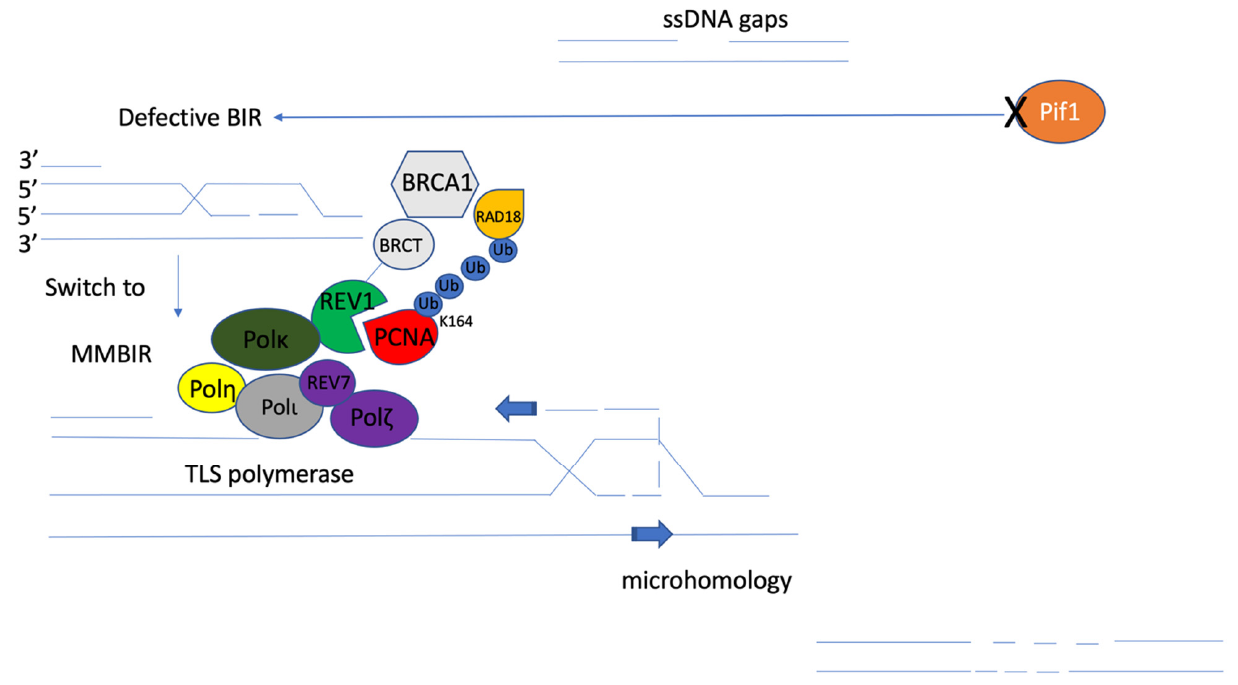
Figure 6. Proposed mechanistic model of microhomology-mediated break-induced replication (MMBIR). The disfunction of Pif1 helicase (orange) leads to template switches involving microhomology from defective BIR. MMBIR is driven by the translesion synthesis (TLS) polymerases Pol ζ and Rev1 [105]. Monoubiquitination of PCNA (red) on lysine 164 (K164) by RAD18/RAD6 (yellow) results in the binding of TLS polymerases to PCNA. TLS activities are mediated by REV1 (green) binding to PCNA through its BRCT domain (grey), and Pol η (bright yellow), Pol ι (dark grey), Pol κ (dark green), or the REV7 subunit of the Pol ζ (purple) complex through distinct C-terminal interaction surfaces through mutagenic repair of primpol-dependent ssDNA gaps [8]. That mutagenic repair could be microhomology-mediated repair, which will support the reestablishment of replication fork stalling and DNA damage lesion bypass.